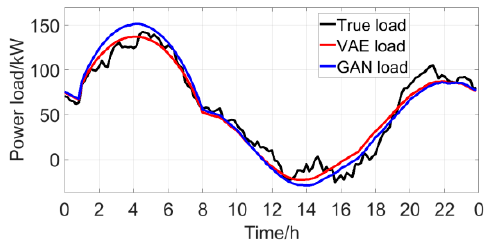
Figure 6. The true load profile and generated load profile.